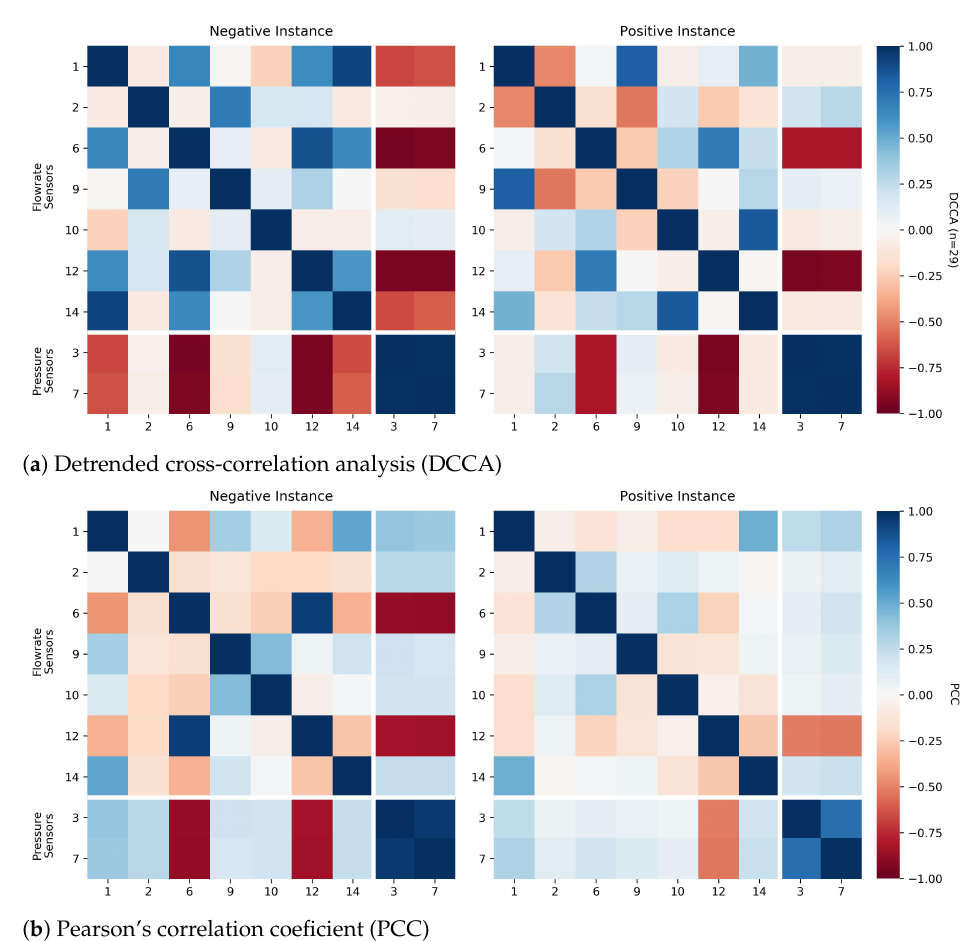
Figure 9. Correlograms of two real instances in 7 February 2017, using a 120 min time window. Negative instance occurs between 10:00 and 12:00, while the positive one between 14:45 and